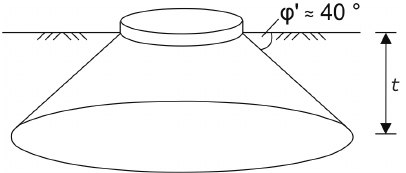
Figure 2. Approximate deformed soil volume subjected to static and dynamic plate load